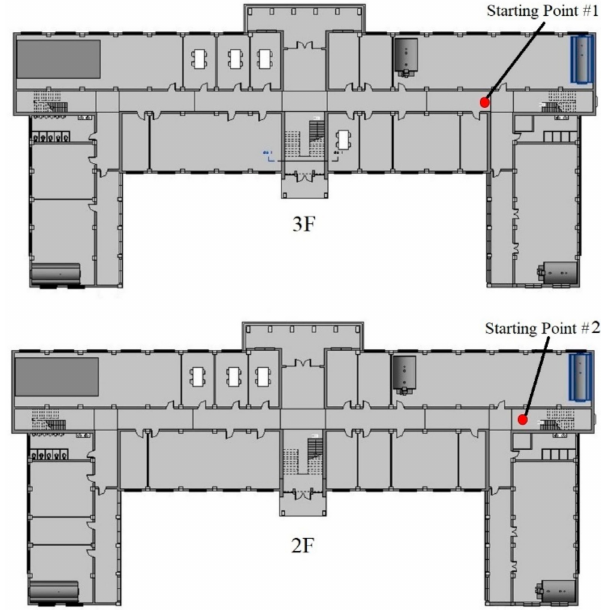
Figure 23. Starting points of evacuation.